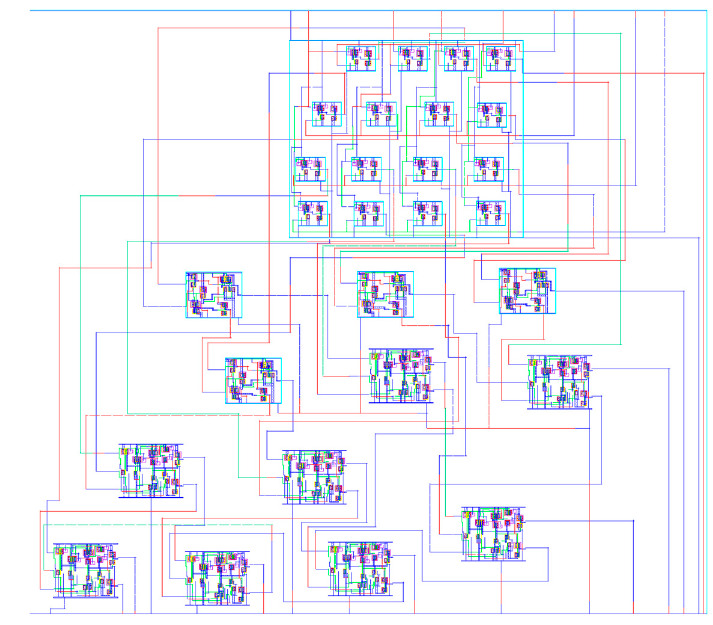
Figure 11. DRC, LVS cleaned, physical design implementation of 4 × 4 Dadda multiplier.